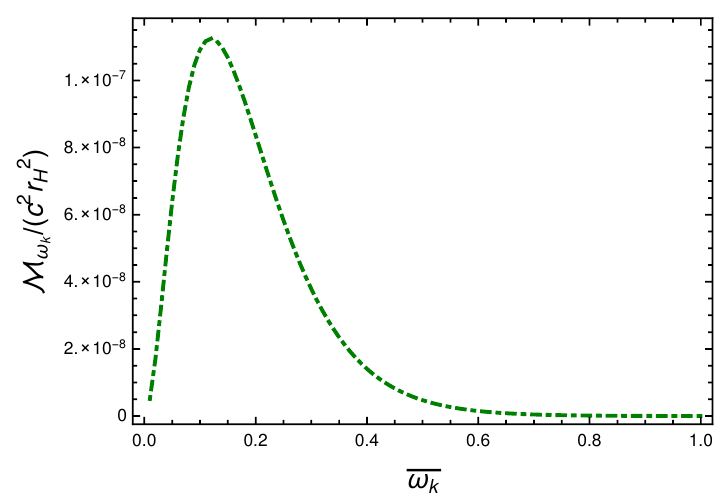
( ρ ) / ( c 2 r 2 ) perceived by two out going null detectors AB H k = r for fixed transition frequency ∆ E = r k H ω k